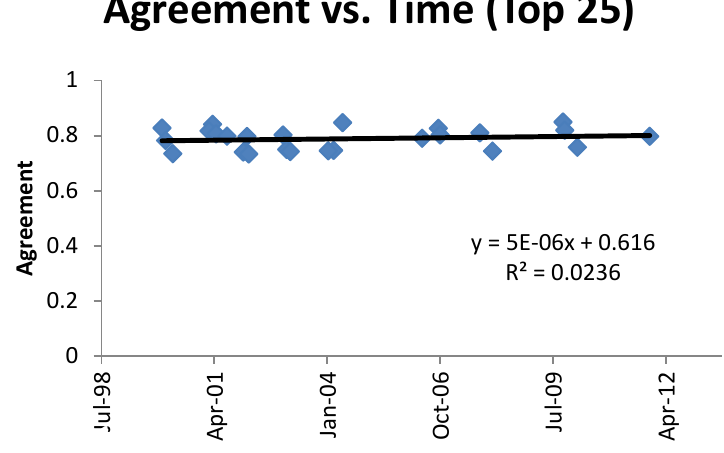
Figure 20. Overall agreement ( i.e. , total agreement at the level of individual study dates) as a function of time for the top 25 dates ranked in terms of overall agreement given the 10-year study period. The residuals are dramatically reduced ( i.e. , are on the order of ±